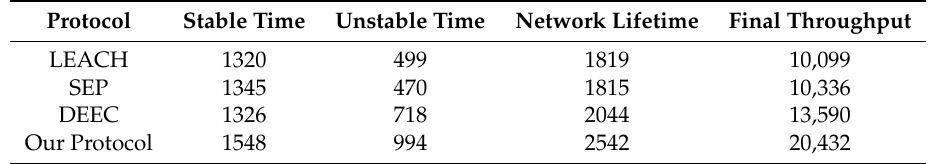
Table 5. A performance comparison between the four clustering protocols in the homogeneous networks (initial energy = 0.8 J).